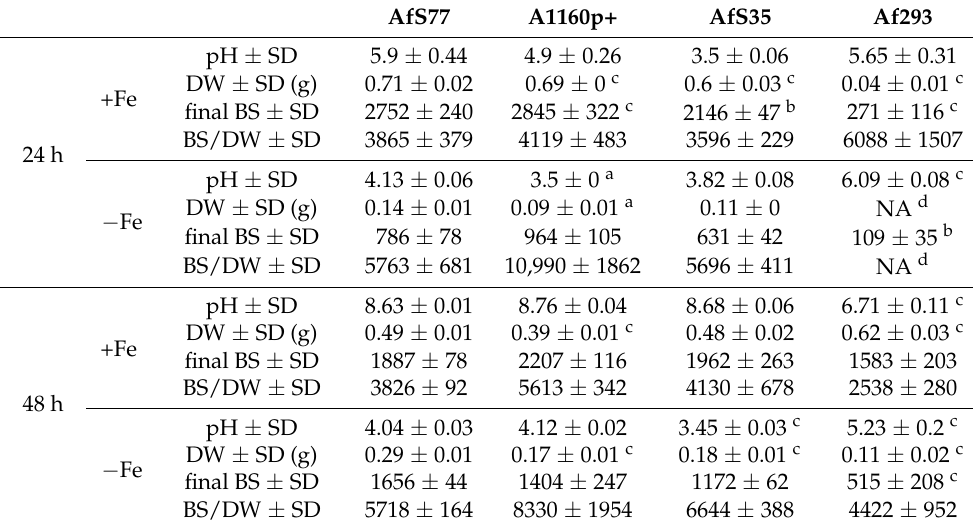
Table 5. Comparison of DW, BS values, BS/DW ratios, and pH values of A. fumigatus AfS77 and A1160p+, AfS35, and Af293 cultured for 24 h and 48 h under +Fe and − Fe conditions. Mean ± standard deviation of biological triplicates is displayed. Statistically significant differences (marked by a , b , or c ) of strains compared to AfS77 were assessed by one-way ANOVA and Tukey’s multiple comparison test.